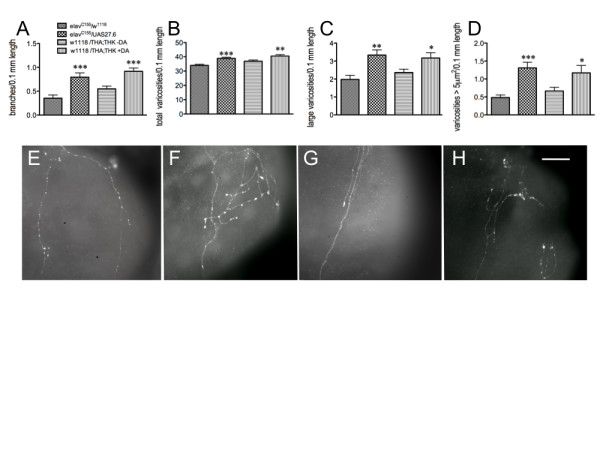
Constitutive induction in neuronal DTH or increased systemic DA during late embryogenesis results in aberrant larval gut fiber architecture. elavC155/UAS27.6, its parental control, elavC155/w1118, and 16 hr old control (w1118;THA;THK) embryos were dechorionated, devitillenized, and exposed to serum-free media with or without 10-6M DA for 6 hours until hatching. A. Branching. B. Varicosity number. C. Large varicosities. D. Varicosities > 5 μm2 in diameter. elav/w1118, 28 fibers from 22 guts from 4 independent experiments; elavC155/27.6, 40 fibers from 32 guts from 7 independent experiments; w1118/THA;THK -DA, 45 fibers from 26 guts from 9 independent experiments; w1118/THA;THK + DA, 44 fibers from 34 guts from 13 independent experiments. *p < 0.05, **p < 0.01, ***p < 0.001, Student's unpaired t-test, comparing elav/w1118 with elavC155/UAS27.6 and w1118/THA;THK -DA with w1118/THA;THK + DA. Lines above the graph depict standard error of the mean. E - H. Visual depiction of 5-HT axonal fibers from elav/w1118 (E), elav/UAS27.6 (F), w1118/THA;THK -DA (G) and w1118/THA;THK + DA (H) guts. Scale bar = 30 μm.